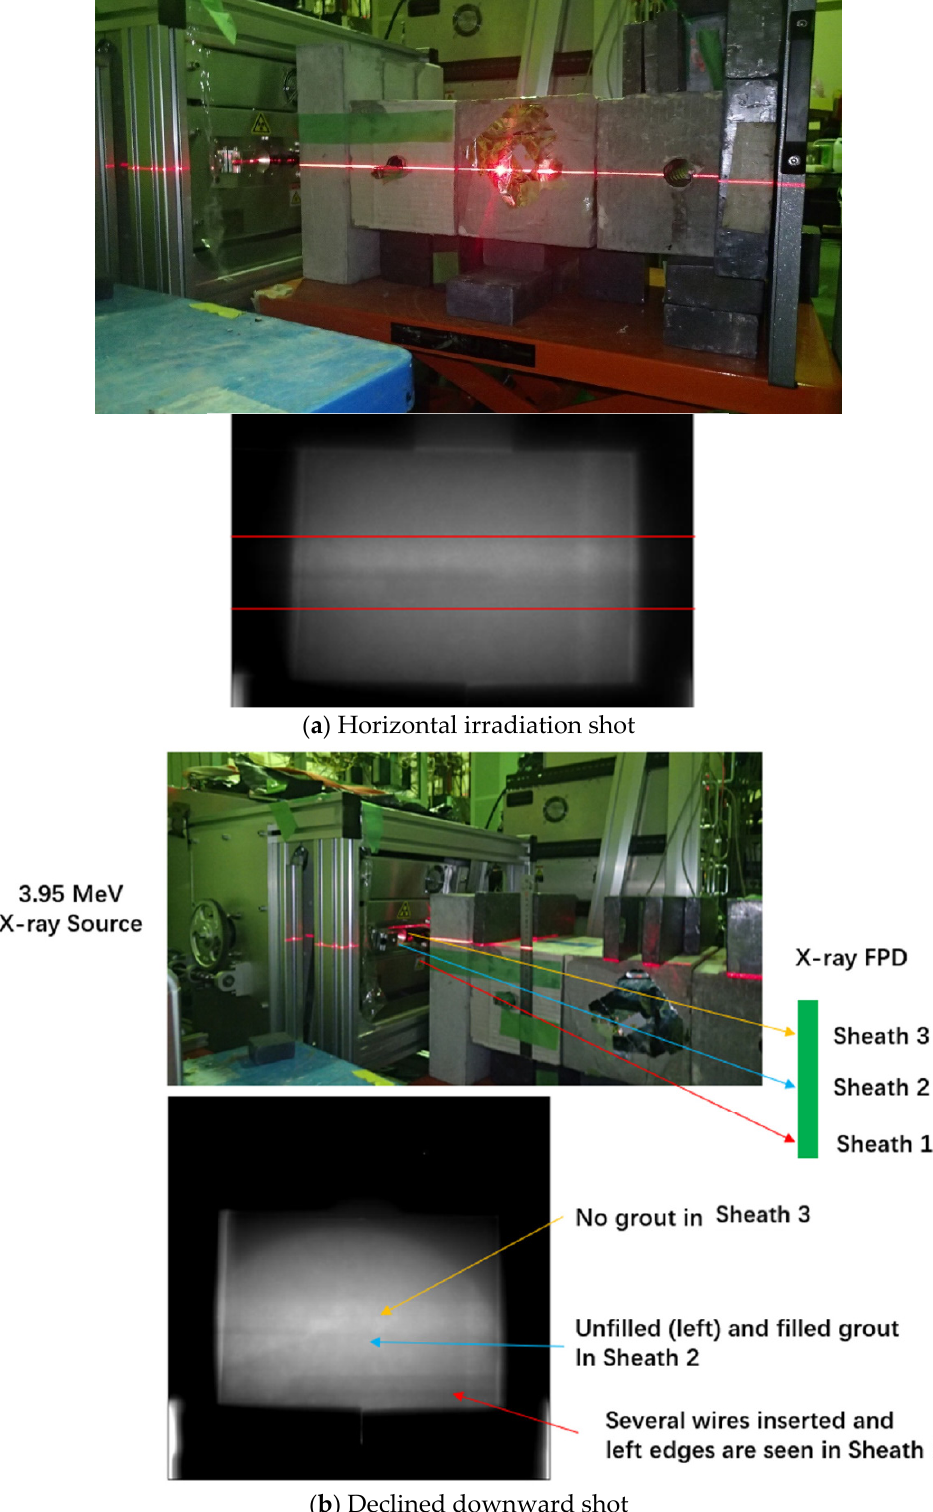
Figure 34. Photograph and X-ray image by 3.95 MeV X-ray source for 750 mm thick model sample for box-shape PC girder bridge. There are three sheaths. ( a ) Horizontal shot. The three sheaths are overlapped and only Sheath 1 can be seen. ( b ) Declined downward X-ray shot to shift the three sheaths at the